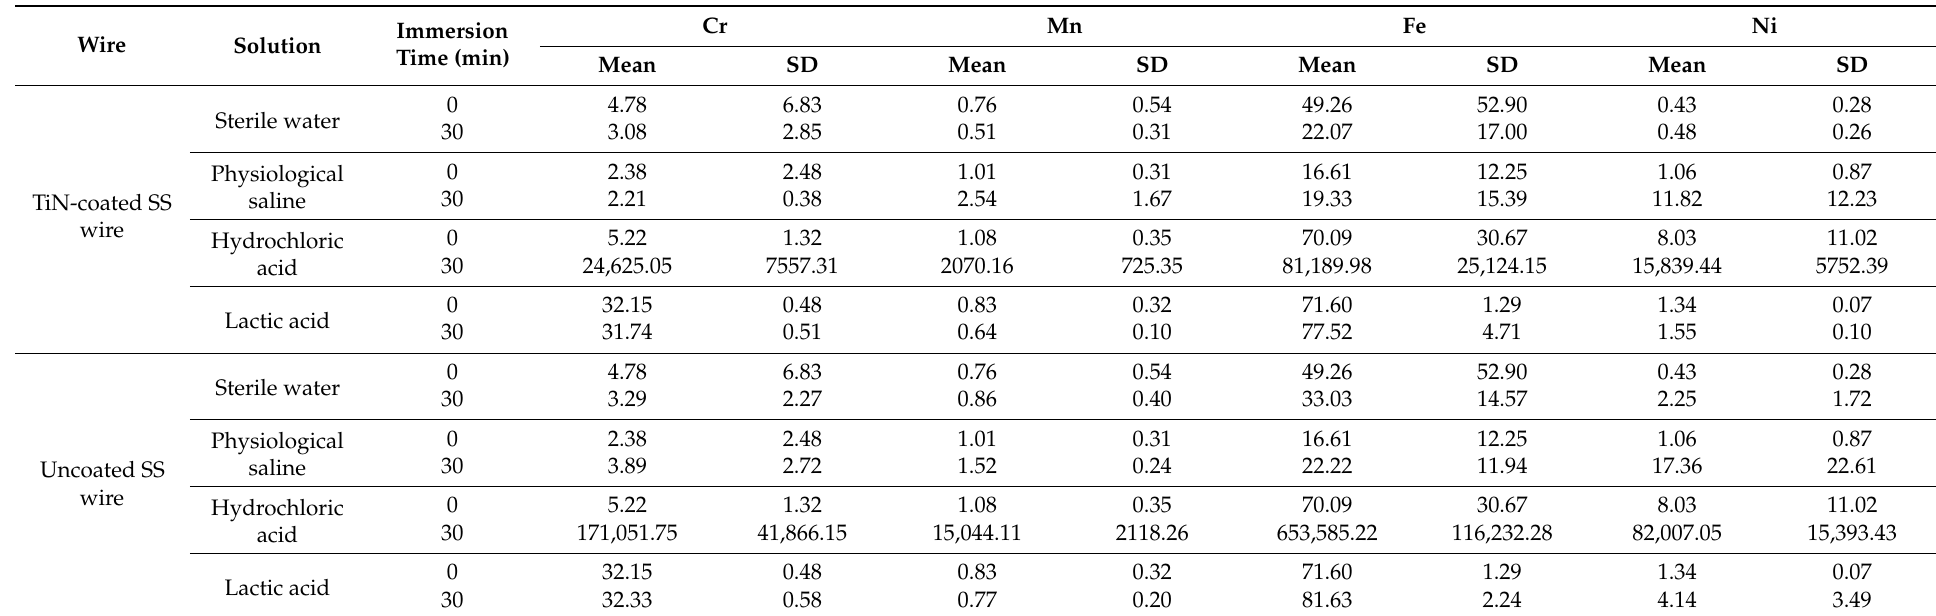
Table 1. Metal ion release from SS wire ( µ